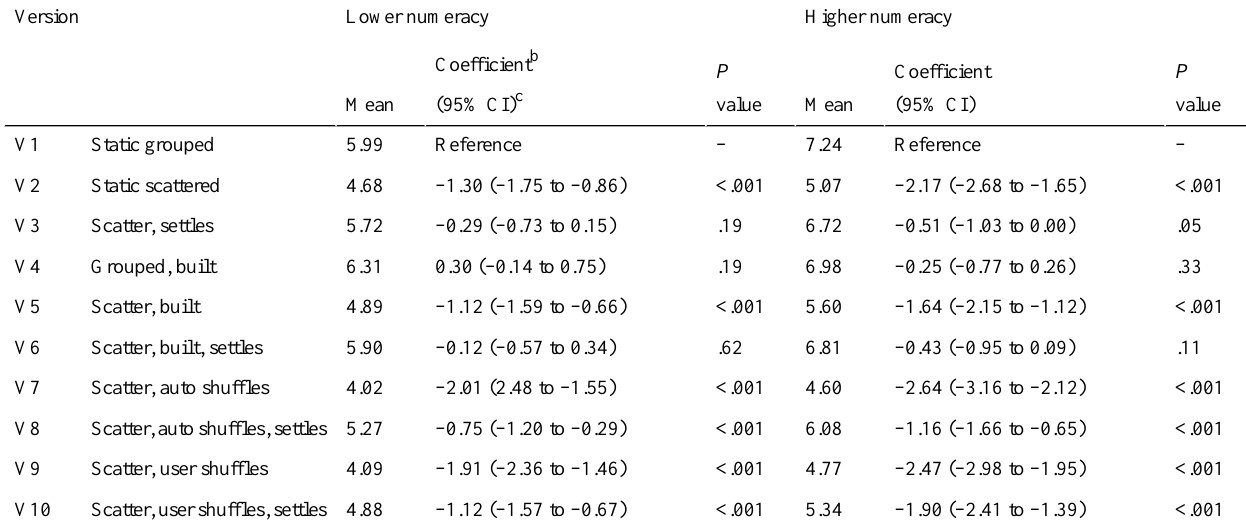
Table 6. Graph evaluation ratings a , by graph version and respondent numeracy.